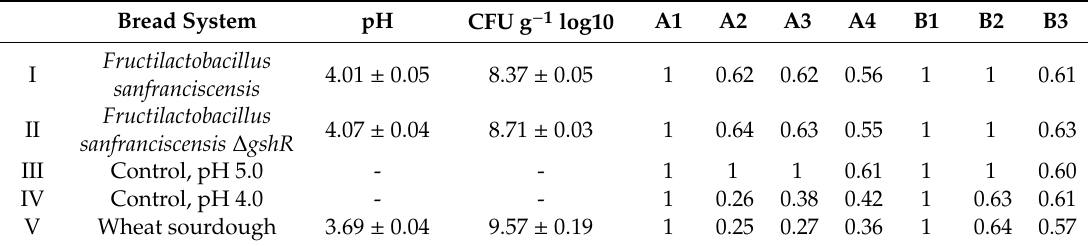
fermentation in the presence of Pepstatin-A and E-64 indicated that the conversion of tetrameric ATI to smaller subunits was dependent on aspartic proteases (Figure 2B).